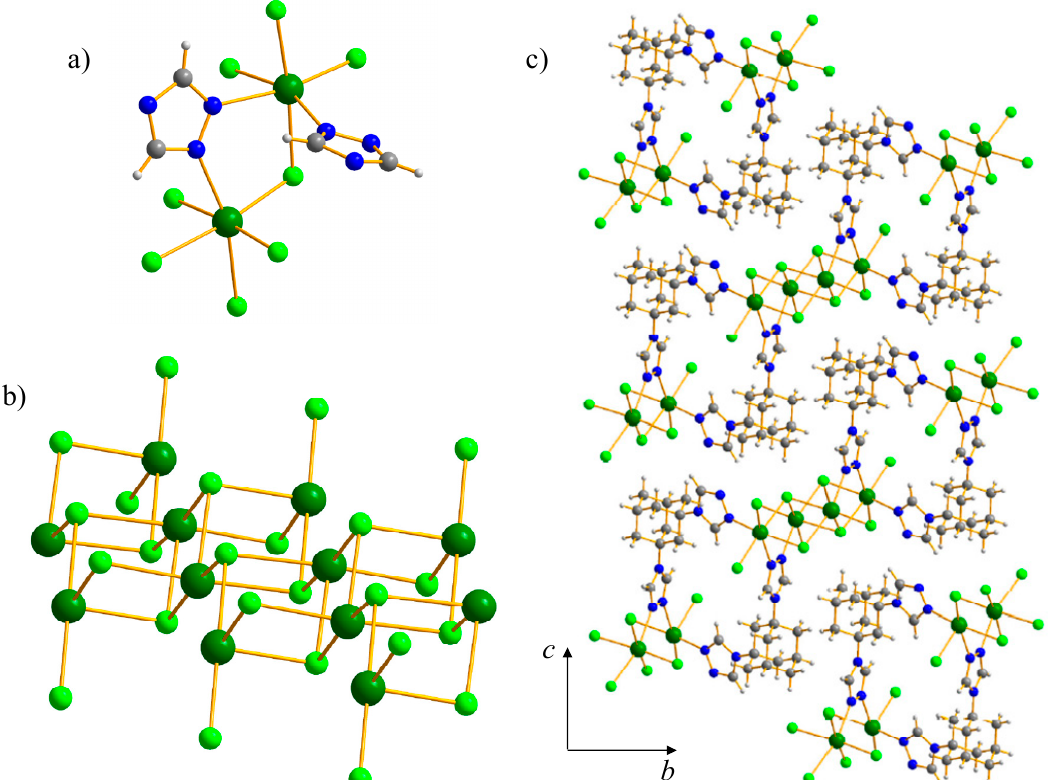
Figure 6. Representation of the crystal structure of [Cd 2 (tr 2 ad)Cl 4 ] n : ( a ) the coordination sphere of the metal ions; ( b ) portion of the 1-D polymeric strands; ( c ) portion of the packing, viewed along the [100] crystallographic direction. Horizontal axis, b ; vertical axis, c . Atoms colour code: C, grey; H, light grey; Cl, light green; Cd, green; N, blue. Main bond distances (Å) and angles (°) at the metal ions: Cd1–Cl 2.59(2), 2.62(2), 2.75(2), 2.82(2), 2.87(2); Cd1–N 2.42(3); Cd2–Cl 2.58(2), 2.59(1), 2.62(2),